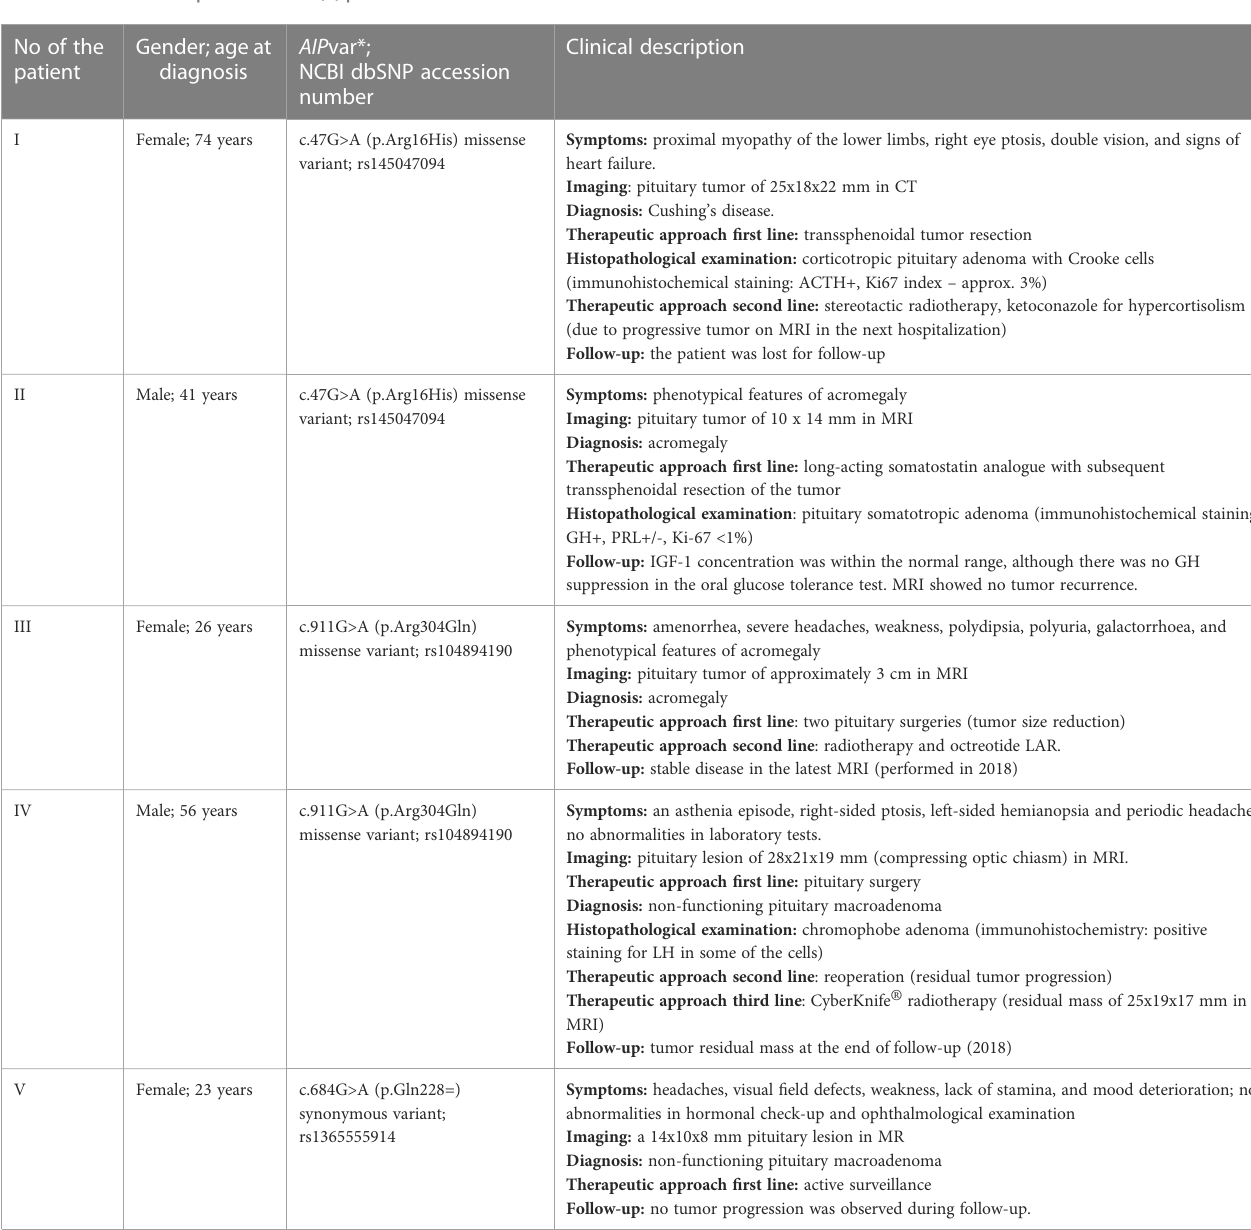
TABLE 1 Clinical description of AIP var(+)